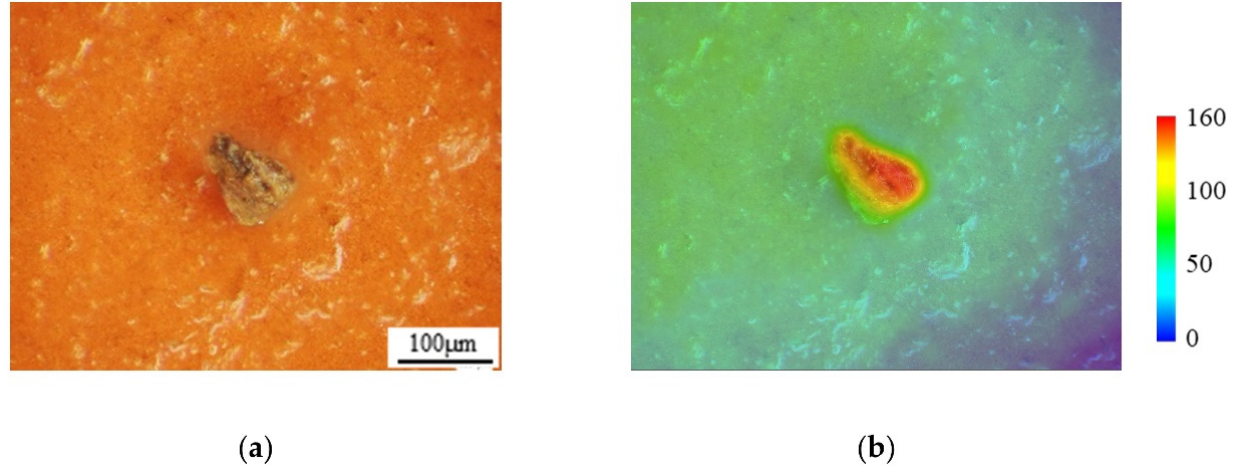
Figure 21. Surface morphology after immersing in a 3.5 wt% NaCl solution (CST 24 h): ( a ) CST Microscopic image, ( b ) Contour image.